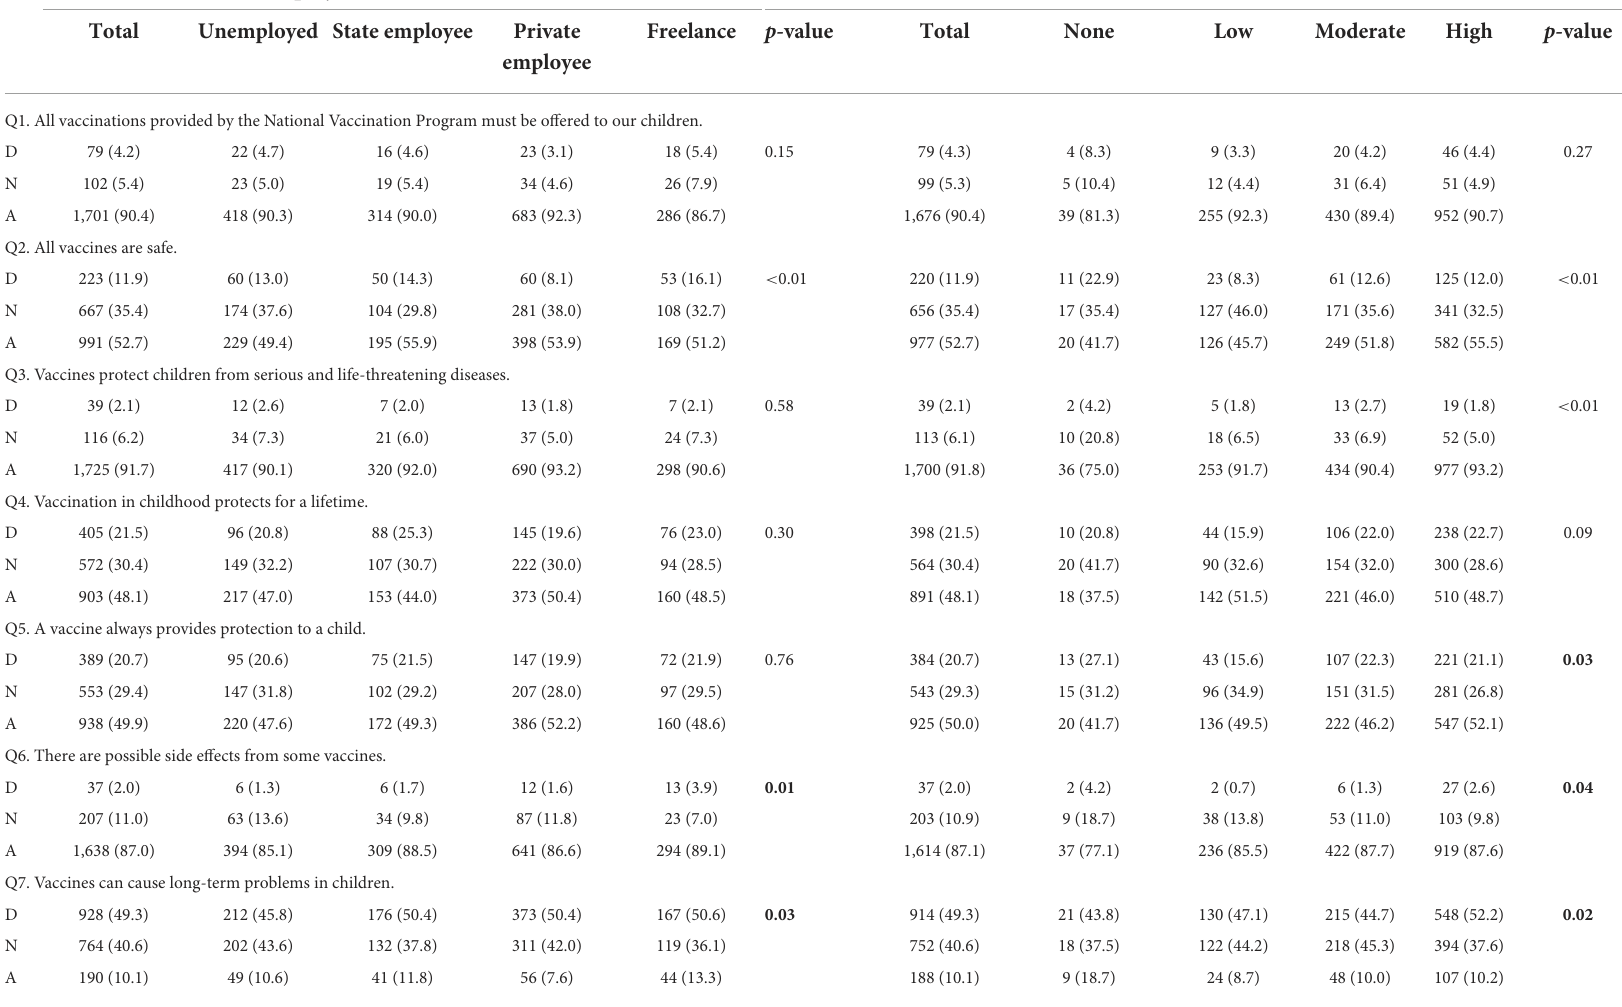
TABLE 3 Maternal responses to questions about vaccination attitudes by employment and income status of the